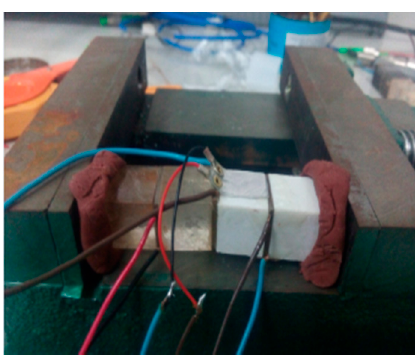
Figure 15. Clamping manner of specimens.